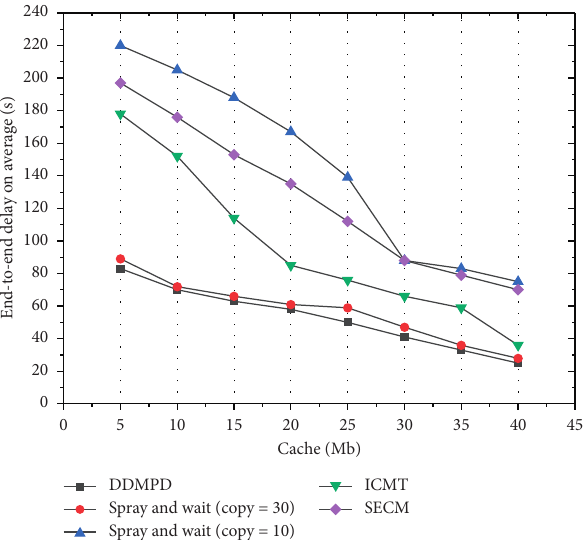
Figure 14: Relationship between end-to-end delay on average and cache.